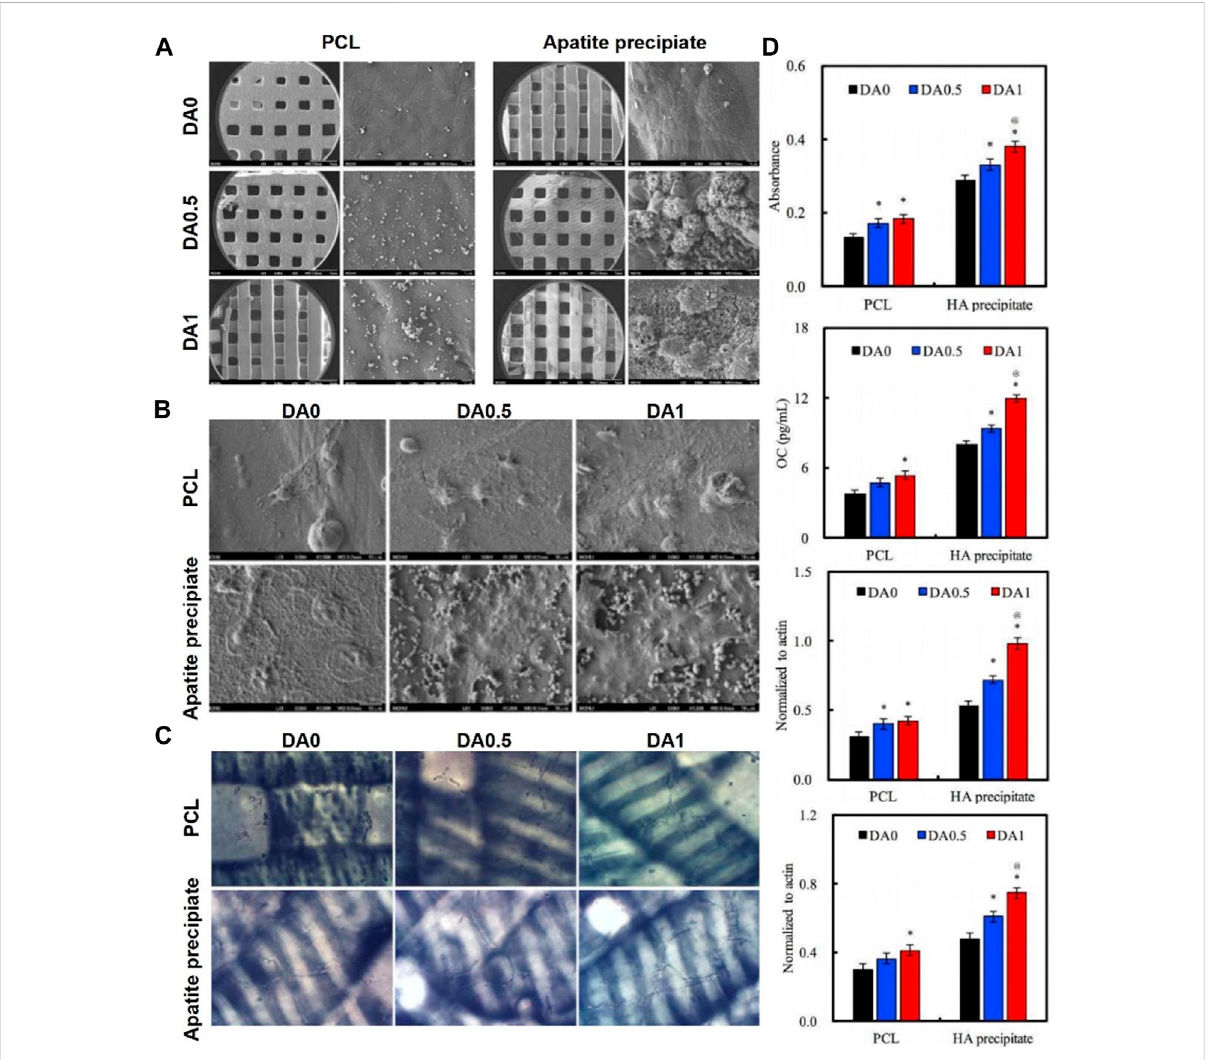
3D-Printed PCL scaffold coated with dopamine enhanced adhesion and differentiation of human mesenchymal stem cell (Cheng et al., 2016). (A) Overall appearance of 3D printed PCL scaffold. (B) SEM images of hMSCs cultured on 3D printed PDA/PCL scaffolds. (C) Vessel-like structures formation ofhMSCscultured on3DprintedPDA/PCL scaffolds. (D) ALP activity, OCamount,BSPexpressionandOPN expressionofhMSCscultured on 3D printed PDA/PCL scaffolds for 7 days. (Reproduced from the references with